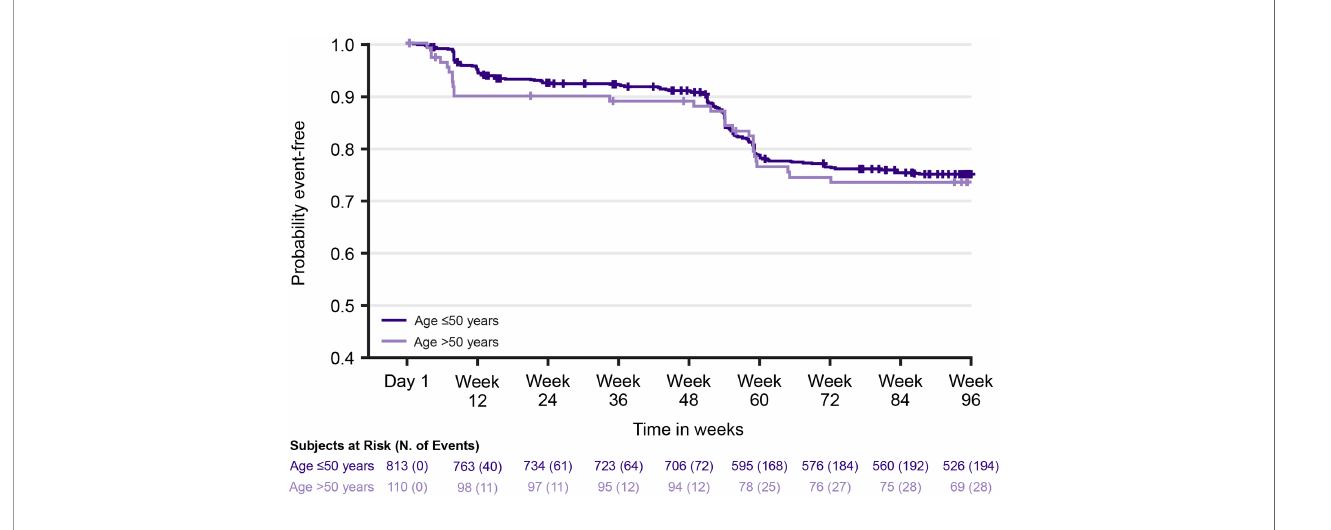
FIGURE 2 | Time to fi rst episode of Grade ≥ 3 lymphopenia with cladribine tablets 3.5 mg/kg by age